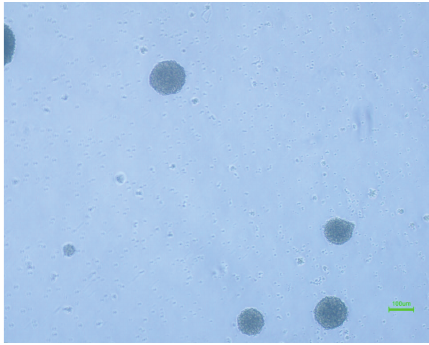
Figure 3: Neurospheres, formed after exposing the breast milk- derived cells to neurogenic medium.